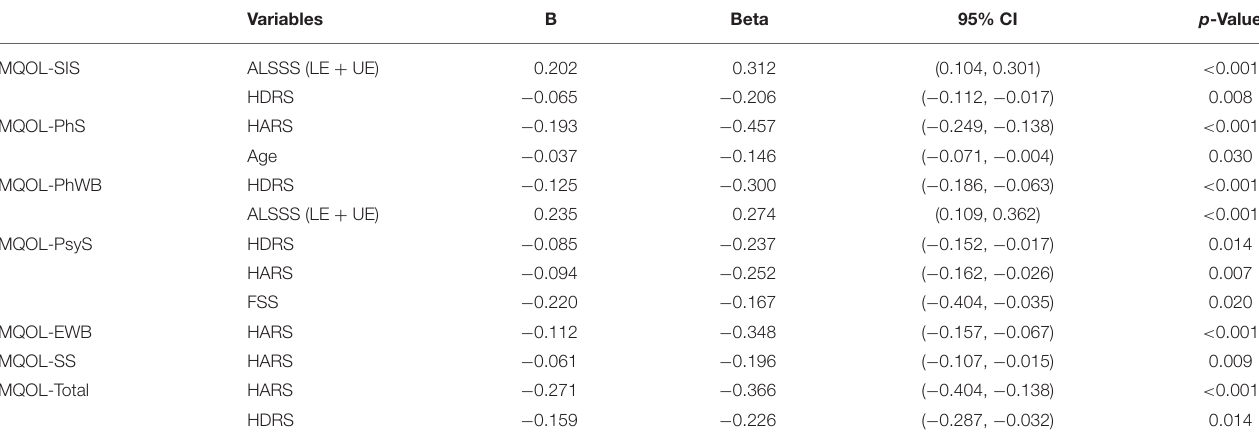
TABLE 6 | The impact of clinical variables on quality of life in the multiple linear regression